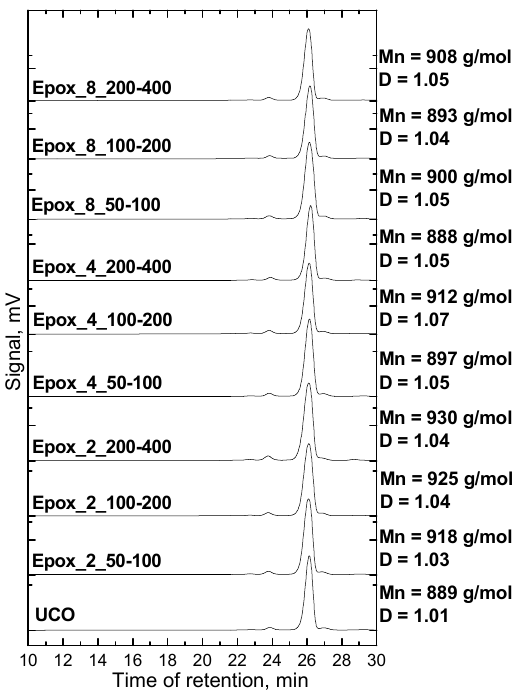
Figure 6. Chromatograms of bio-polyols obtained with Dowex catalysts.